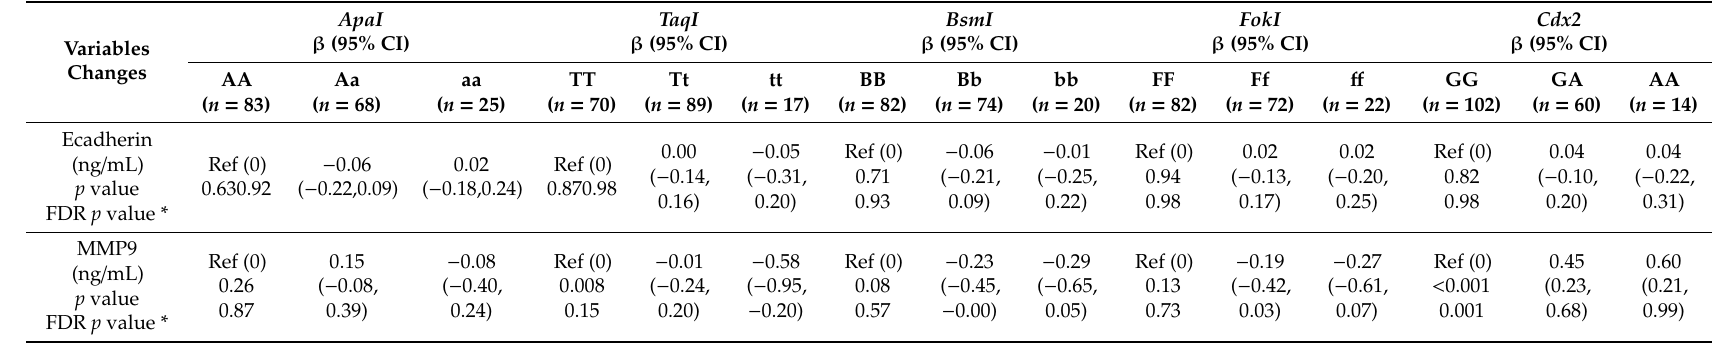
Table 3. Association analyses between vitamin D receptor single nucleotide polymorphisms ( VDR SNP) genotypes and on-study breast cancer biomarkers changes among patients supplemented with vitamin D3 (4000 IU / day for 12 weeks) under codominant model.